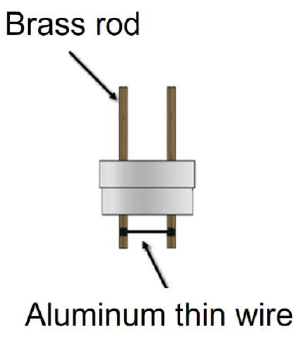
Figure 7. Schematic diagram of the electrodes.